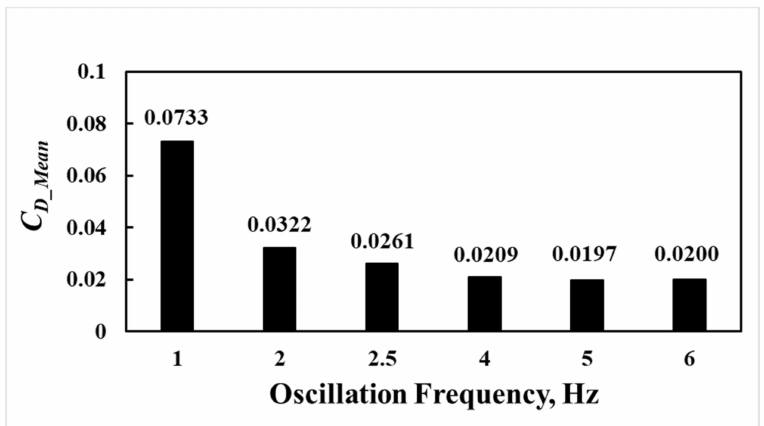
Figure 14. C D vs. oscillation frequency for TLC entrained downstream of the Mean